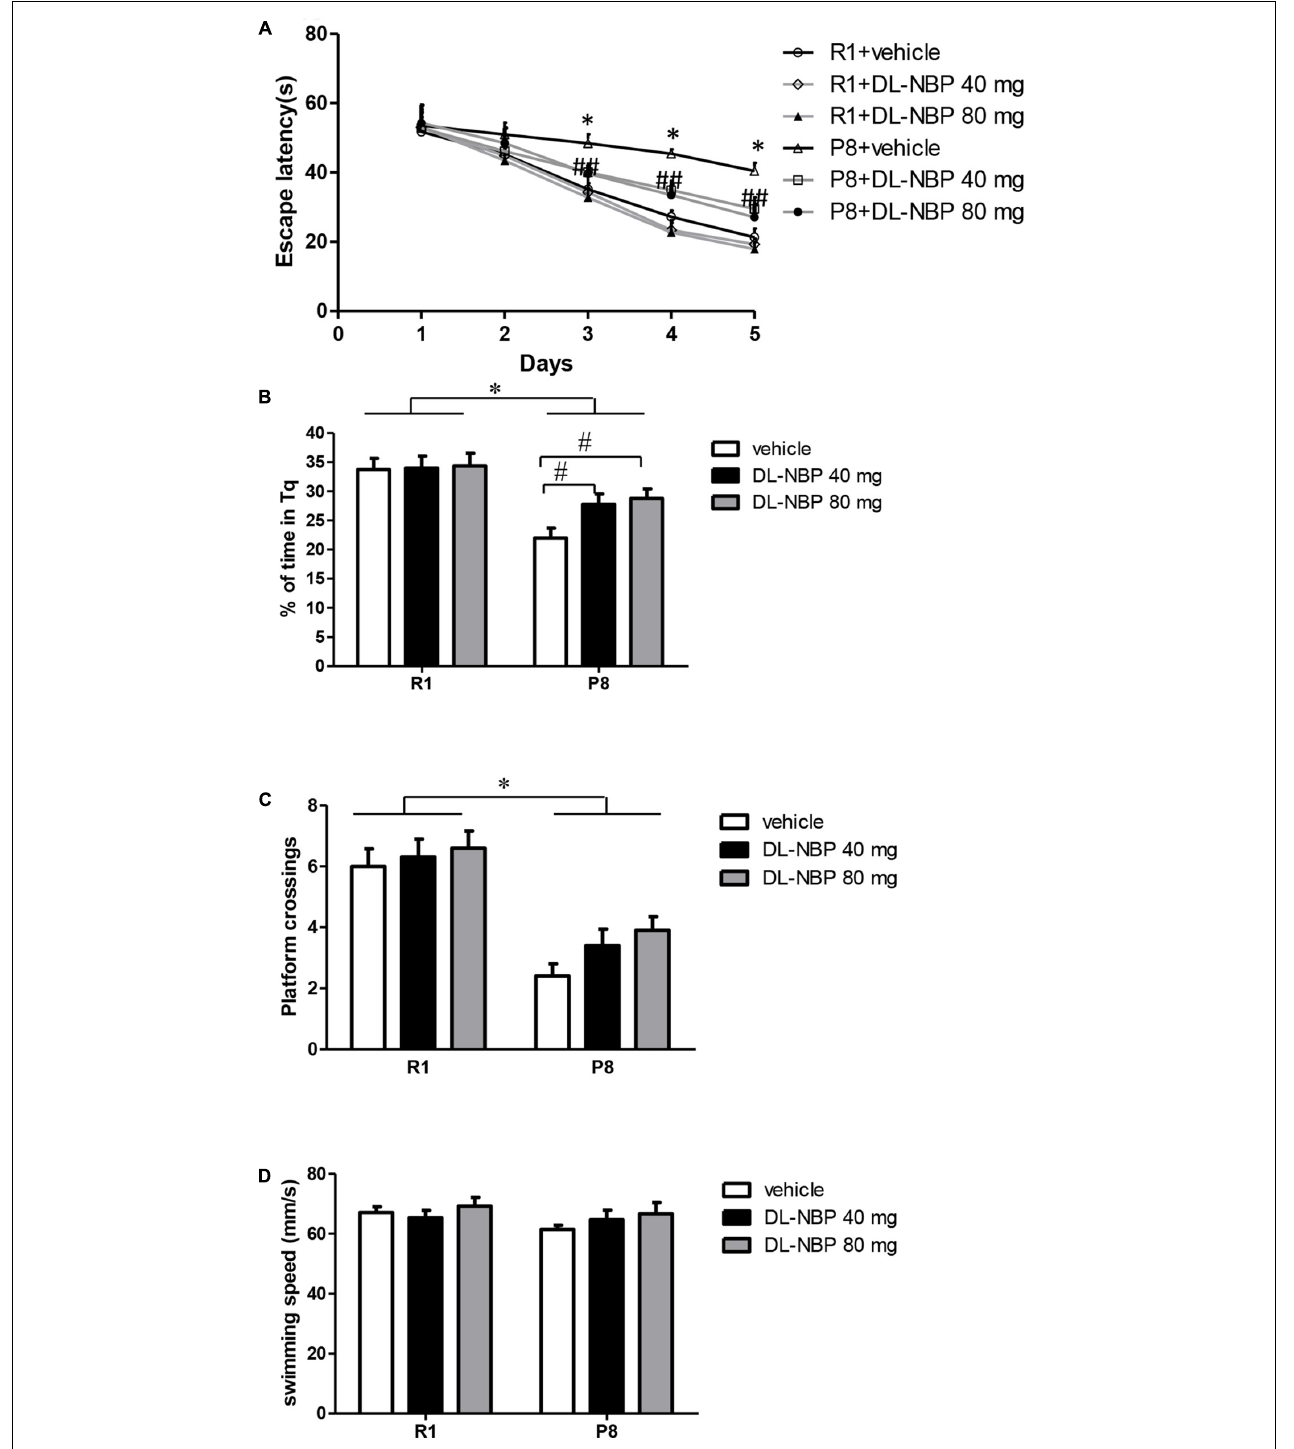
FIGURE 3 | DL-3- n -butylphthalide (DL-NBP) improves spatial learning and memory in senescence-accelerated mouse prone 8 (SAMP8) mice in the Morris water maze. (A) Performance in orientation navigation tests evaluated by the average escape latencies of five consecutive days of four trials each. (B,C) Performance in the probe trial of each group evaluated by the percentage of target quadrant search time (B) and platform location crossings on day 6 (C) . (D) Swimming speed of each group in the MWM test. Statistical significance was determined using repeated-measures ANOVA with post hoc Bonferroni tests. Data are presented as the mean ± standard error of the mean (SEM). ∗ p < 0.01 versus R1 group, # p < 0.01, BL-NBP 40 mg versus P8 vehicle group, and ## p < 0.01, BL-NBP 80 mg versus P8 vehicle group. Tq, target quadrant; R1, SAMR1 mice; P8, SAMP8 mice ( n = 10).